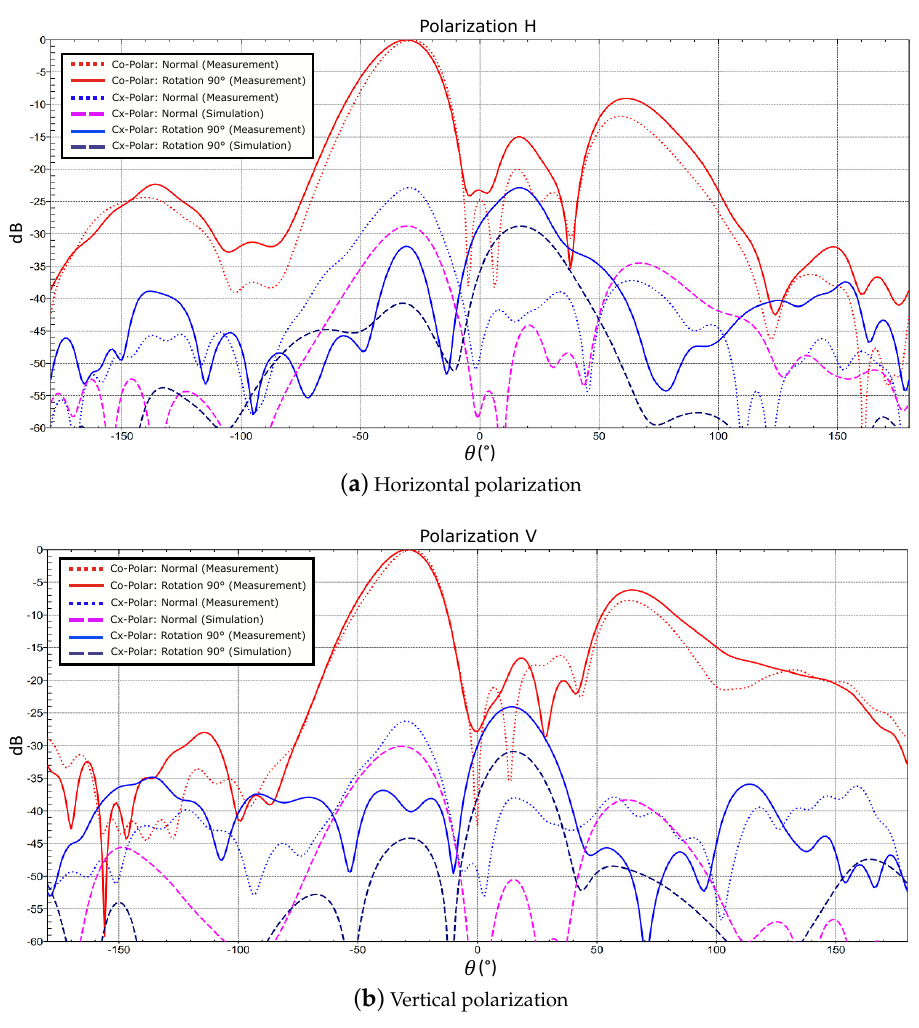
Figure 17. Comparison normal array and array with sequential 90° rotation @ f 0 = 1.325 GHz: normalized co-polar & cross-polar patterns ( ϕ = 90 ◦ ).